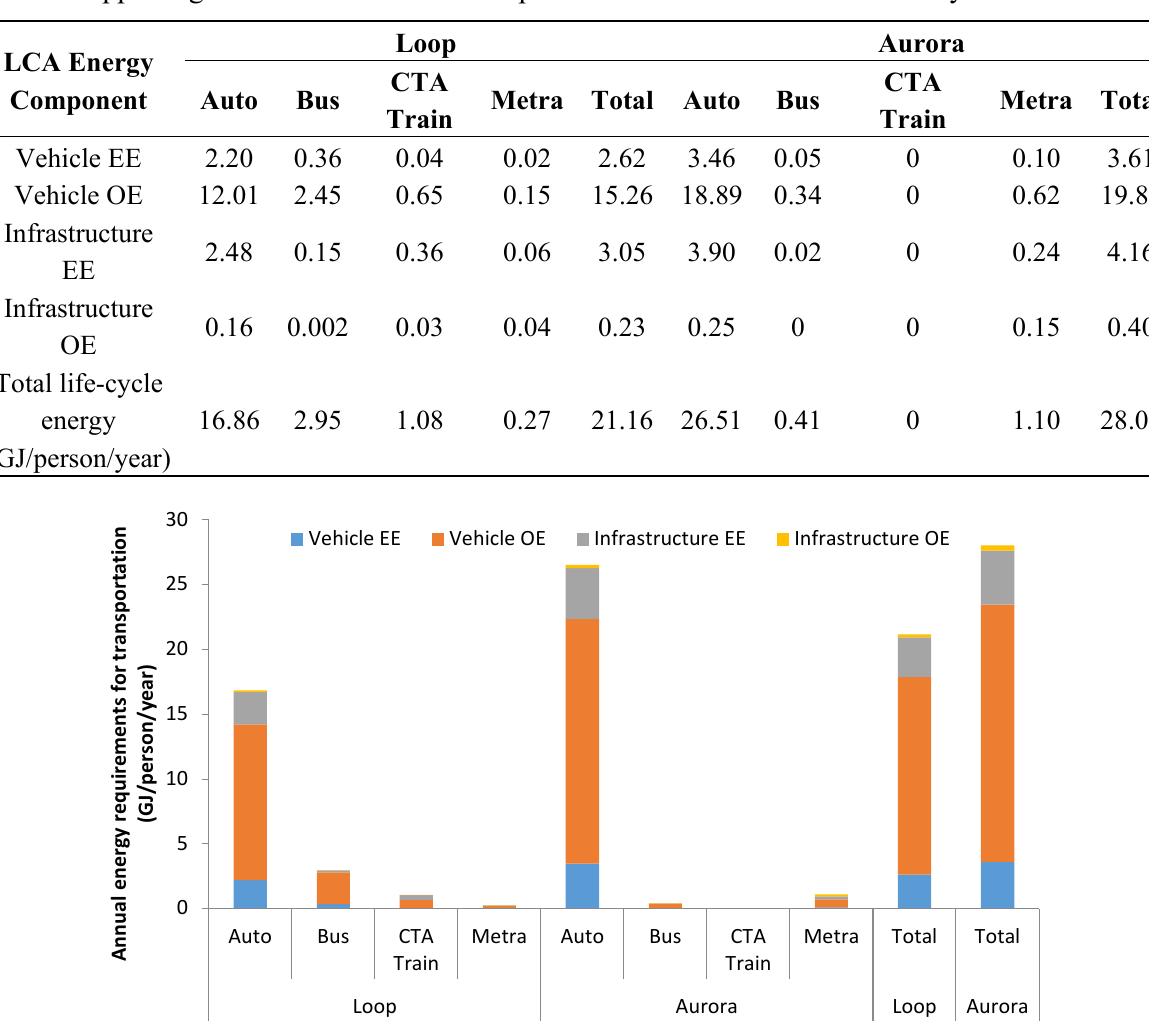
Figure 8. Estimated annual embodied and operational energy (GJ/person/year) for all transportation modes across the two study